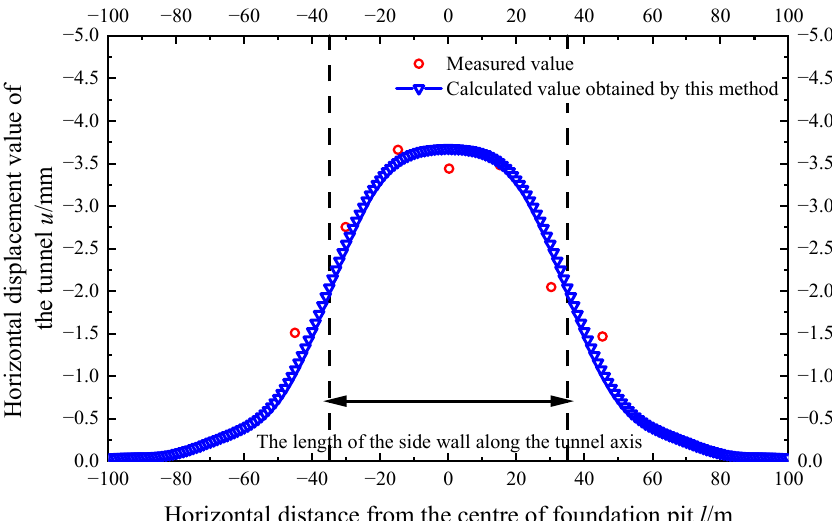
Figure 12. Comparison of the calculated and measured values of the horizontal displacement of the tunnel beside the foundation pit in case 3.